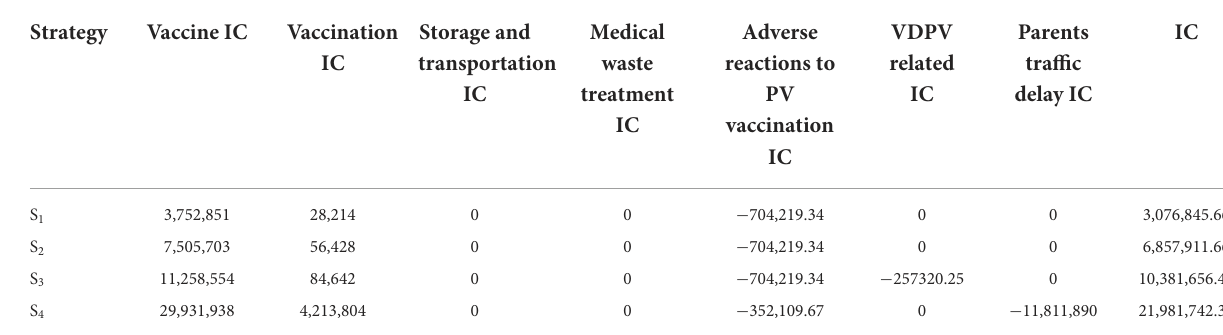
TABLE 3 IC of S 1 /S 2 /S 3 /S 4 (CNY).